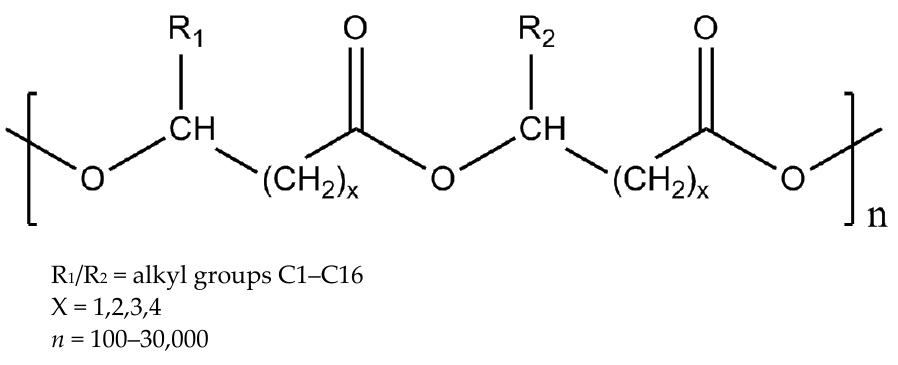
Figure 2. General chemical structure of poly-3-hydroxyalkanoates (PHAs) [6].